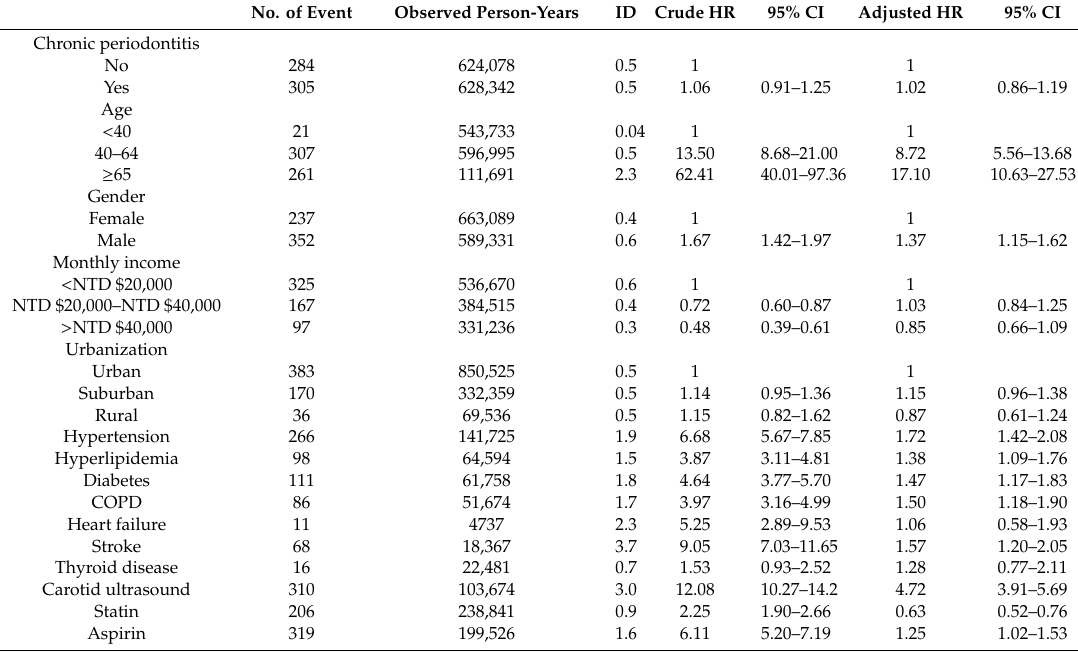
Table 2. Risk factor analysis of carotid atherosclerosis.